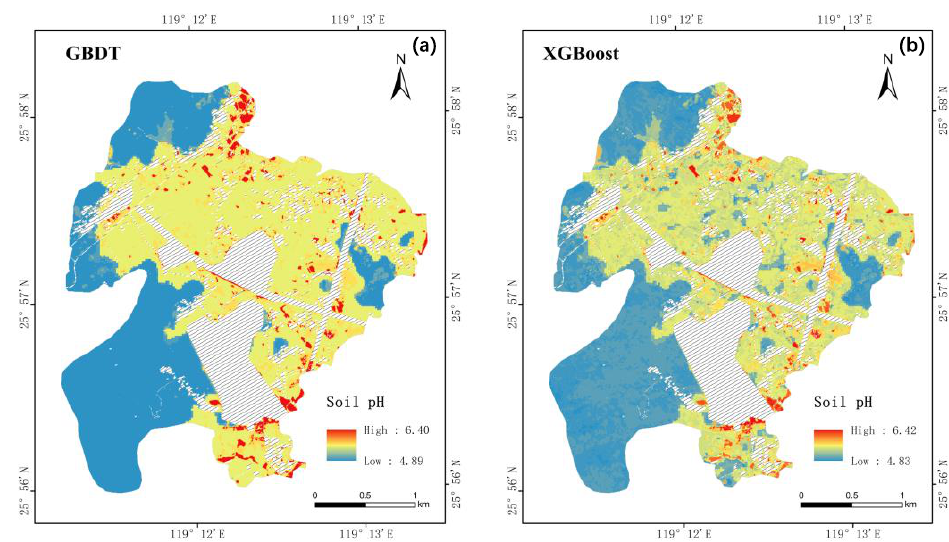
Figure 5. Map of the XGBoost and GBDT models for predicting soil pH based on SVM-RFE feature selection, excluding building sites. ( a ) GBDT: gradient boosting decision tree; ( b ) XGBoost: extreme gradient boosting.